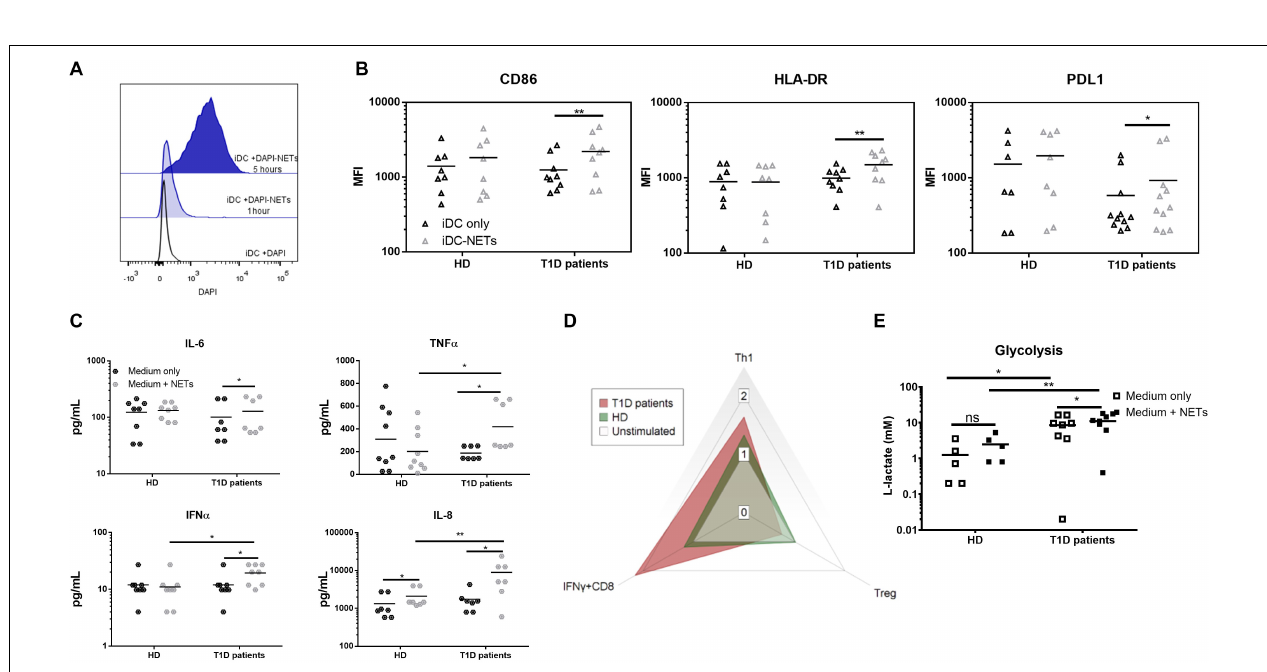
FIGURE 1 | Shift in T lymphocyte populations. Populations of (A) Th1 (IFN γ +CD4), (B) IFN γ -producing CD8+ lymphocytes, (C) Th17 (IL-17+CD4), (D) T regulatory lymphocytes (Tregs) (CD4+FoxP3+CD25 hi CD127-) with (E) CD25 expression on their surface were analyzed by flow cytometry in cultures from 20 T1D patients (55% female) and 12 healthy donors (50% female) after 7 day cultivation with or without autologous NET fragments. (F) Induction of Th1, Th17, Treg, and IFN γ +CD8 T cells isolated CD3+ lymphocytes co-cultured with or without autologous NETs for 7 days in T1D patients ( n = 7) evaluated by flow cytometry. Statistical analysis was performed using a two-tailed Wilcoxon paired t -test and an unpaired t -test. Values of p < 0.05 (*), p < 0.01 (**) and p < 0.001 (***) were considered statistically significant.